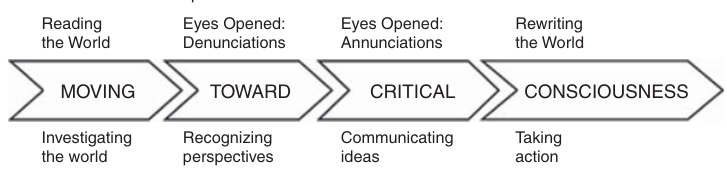
representation of critical cosmopolitan